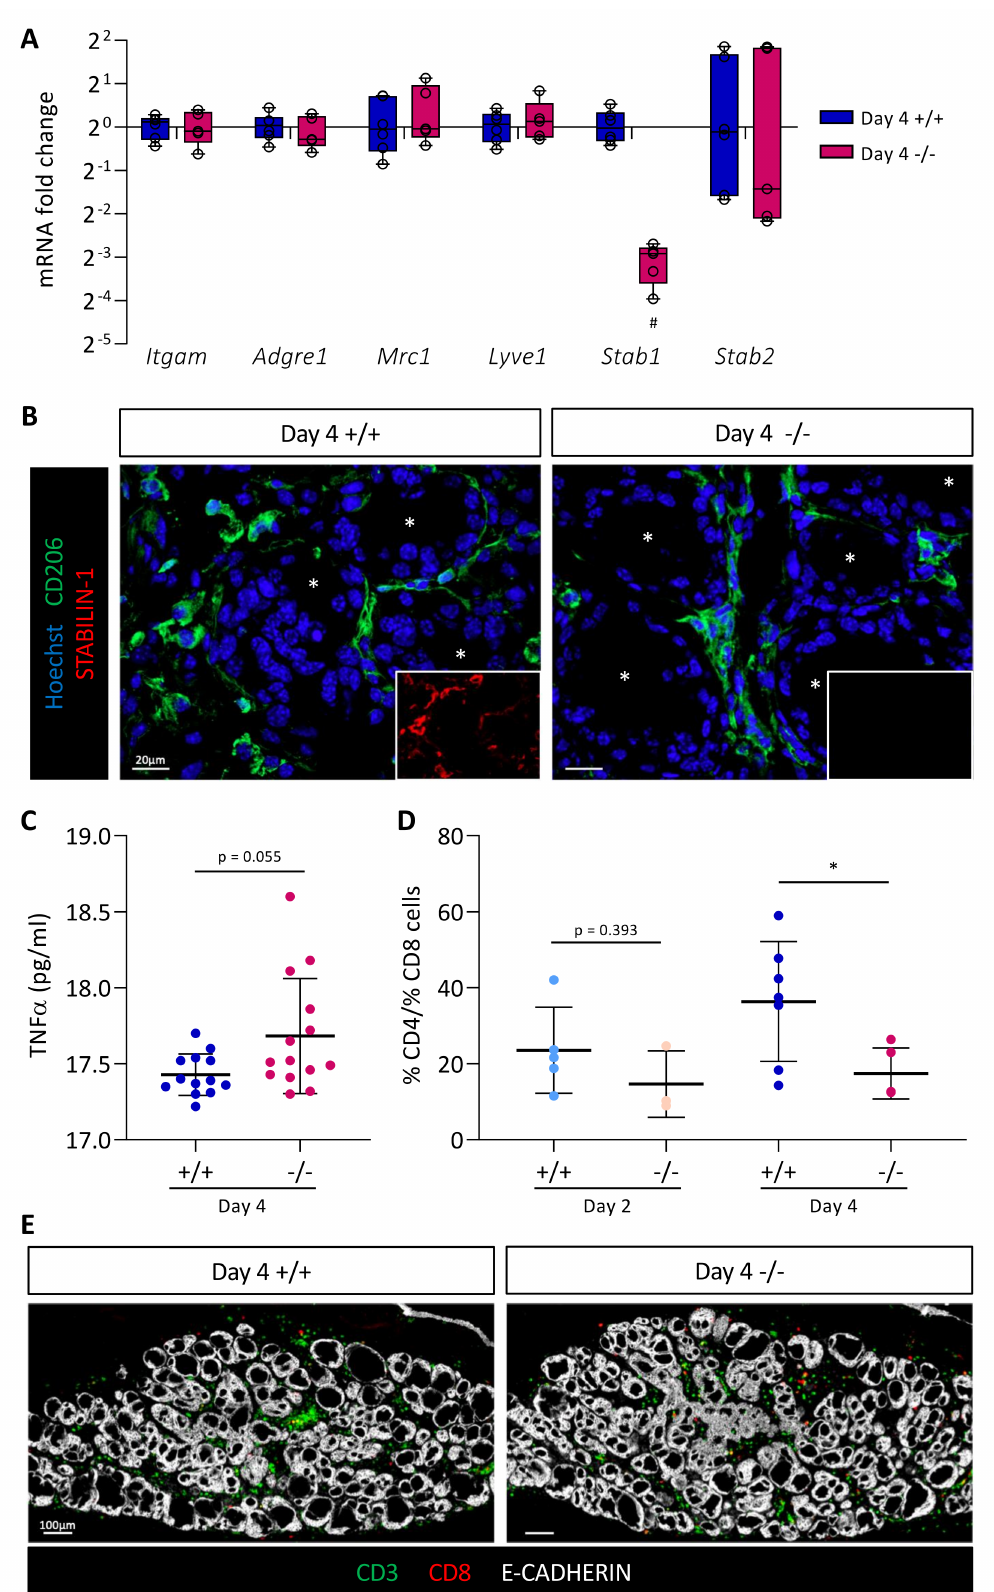
Figure 5. Absence of STABILIN-1 does not affect macrophage recruitment during PTC induction but changes the ratio of CD4+ T cells to CD8+ T cells. ( A ) RT-qPCR analyses of macrophages markers and Stabilin-2 ( Stab2 ) genes in thyroid tissues from wildtype (+/+) and knockout ( − / − ) mice